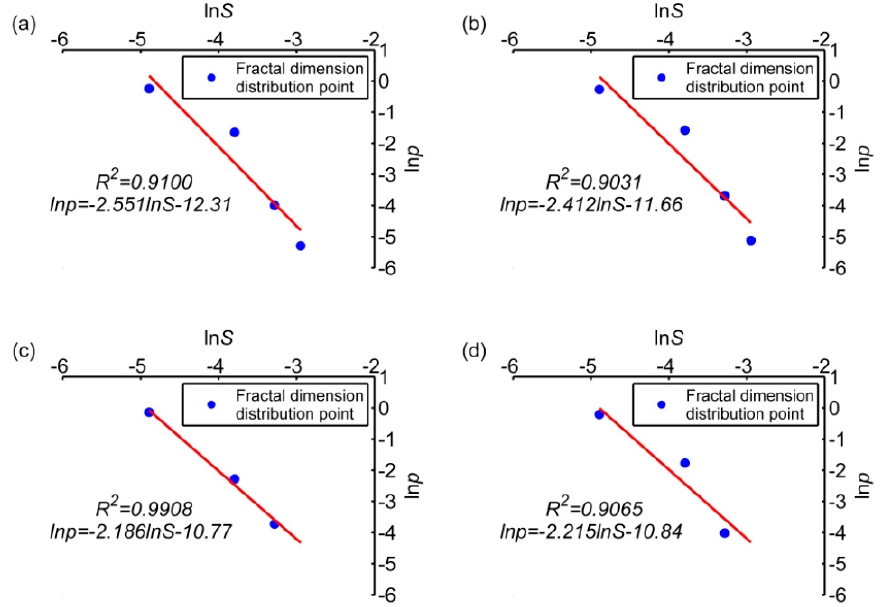
Figure 10. Fractal distribution characteristics of sizes of pits; ( a ) specimen L1, 60-day, ( b ) specimen L1, 90-day, ( c ) specimen L2, 60-day, ( d ) specimen L2, 90-day.